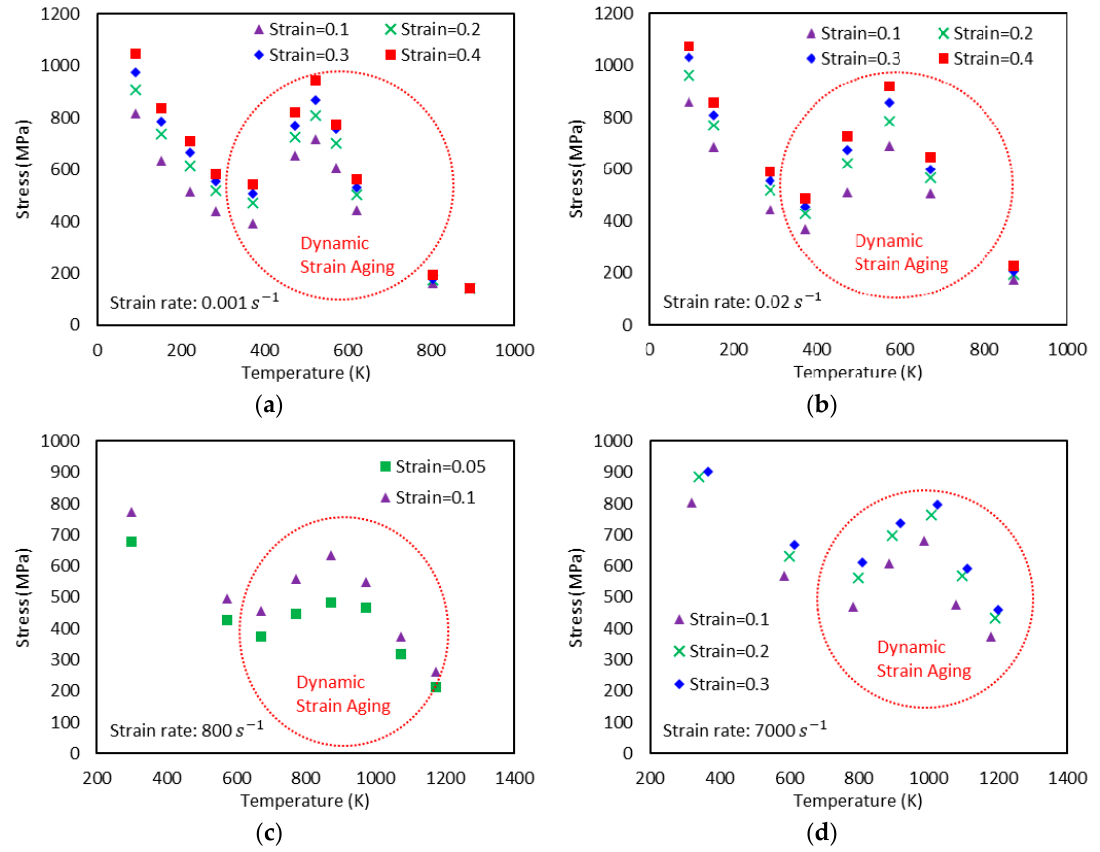
. ε Figure 1. Experimental stress-temperature graphs for Q235B steel for di ff erent strain rates ( ) and strain Figure 1. Experimental stress-temperature graphs for Q235B steel for different strain rates ( (cid:2013)(cid:4662) ) and . ε = . ε = . ε = . ε = levels: ( a ) 0.001 s − 1 , ( b ) 0.02 s − 1 , ( c ) 800 s − 1 , and ( d ) 7000 s − 1 [1]. Dynamic strain aging strain levels: ( a ) (cid:2013)(cid:4662) = 0.001 (cid:1871) (cid:2879)(cid:2869) , ( b ) (cid:2013)(cid:4662) = 0.02 (cid:1871) (cid:2879)(cid:2869) , ( c ) (cid:2013)(cid:4662) = 800 (cid:1871) (cid:2879)(cid:2869) , and ( d ) (cid:2013)(cid:4662) = 7000 (cid:1871) (cid:2879)(cid:2869) [1]. Dynamic (DSA) is observed in all strain aging (DSA) is observed in all cases.